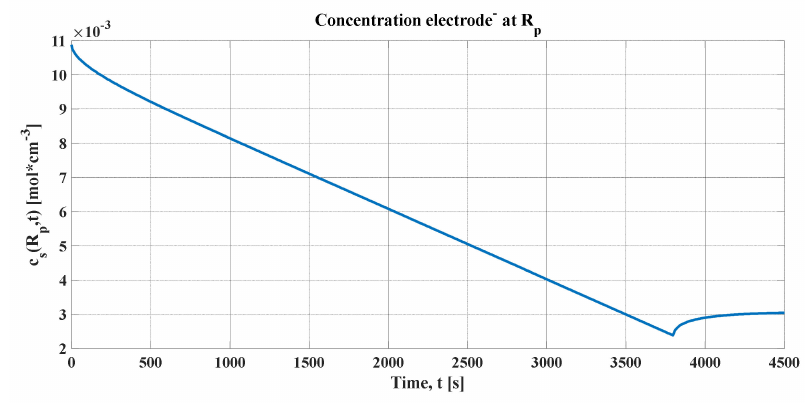
Figure 10. Electrochemical cell concentration (SPM).